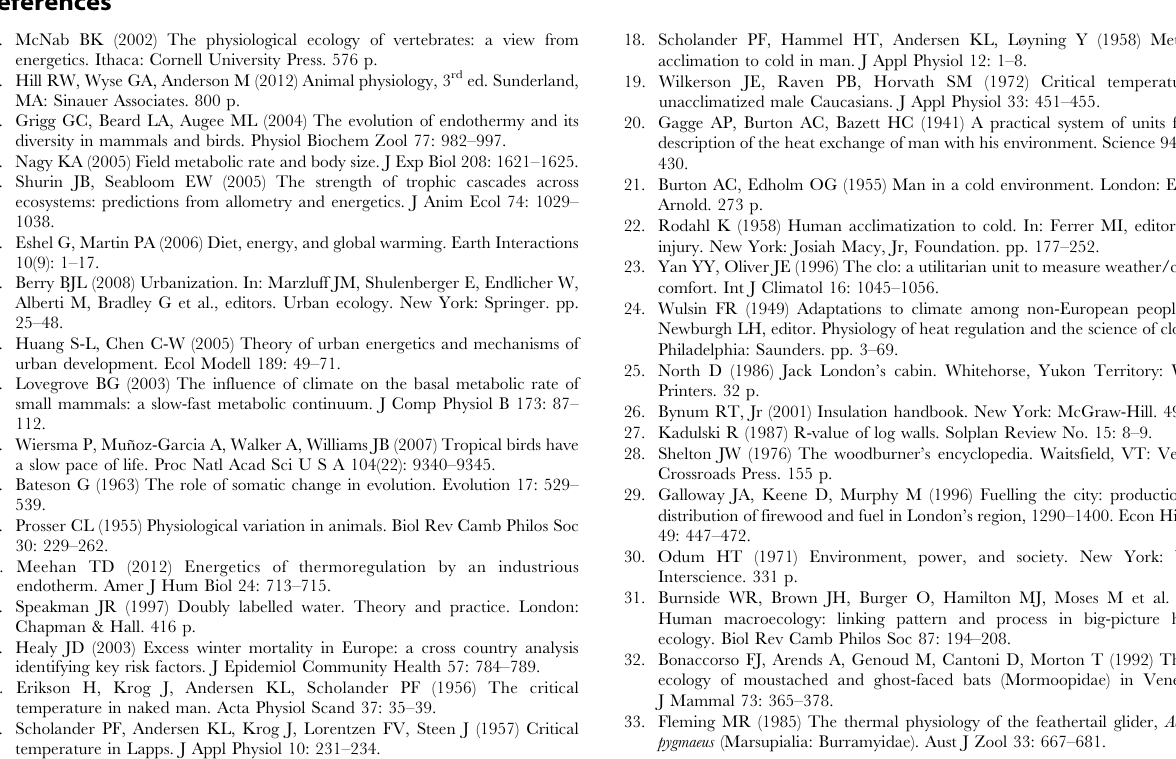
T a data used were for all dates in the 10-year period 2000-2009. Table S2 Derivation of energy- T a plots for clothed people. The insulation of clothing is typically expressed in clo units [23]. From the fundamental equations for clo calculations [20–21], the following equation can be derived to calculate the ‘‘comfort temperature,’’ T comfort – the T a at which a clothed, sitting, resting person will be comfortable (e.g., neither shivering